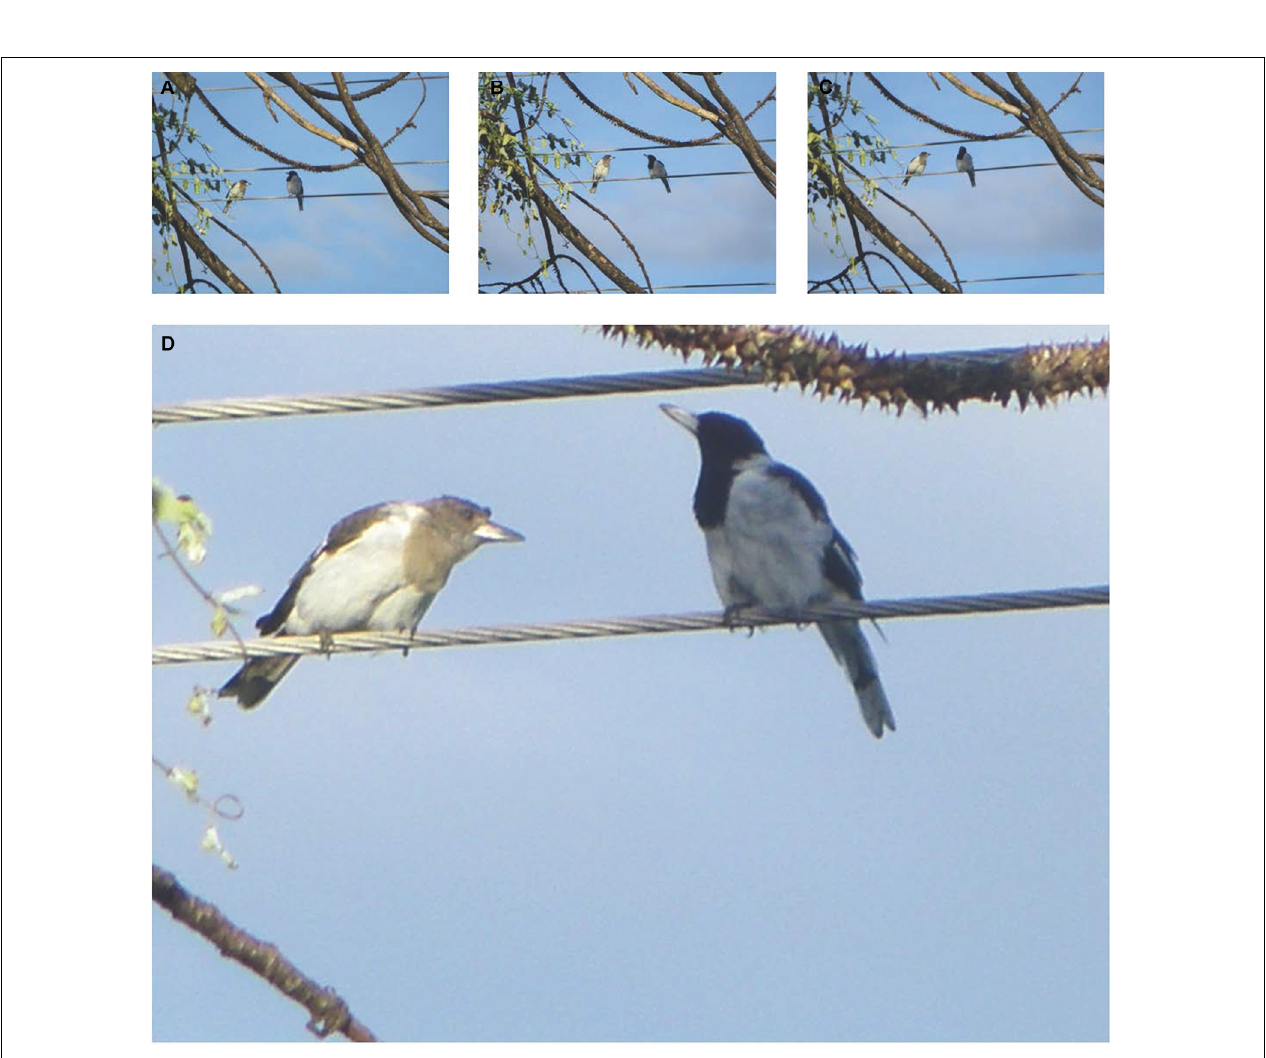
FIGURE 4 | (A–D) An adult pied butcherbird sings whilst an immature bird faces the adult on 25 March 2013.